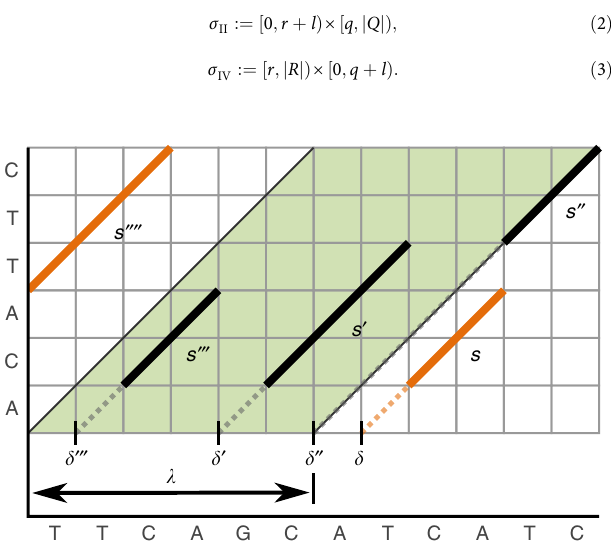
Fig. 6 Strip of consideration (SoC). Seeds are visualized as solid lines. The SoC is the shaded area that comprises the seeds s ′ , s ′′ and s ′′ . The SoC width is equal to λ , where λ is computed on the foundation of the query size and a given scoring scheme. The orange seeds s and s ′′′ are outside of the SoC. The dashed line to the bottom-left of each seed leads to the respective δ -value for this seed. The SoC score is the accumulated length of seeds within the SoC. In this example, the SoC score is seven